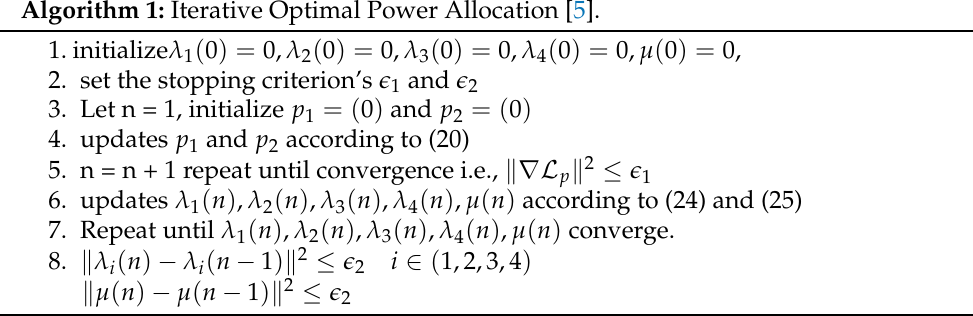
Algorithm 1: Iterative Optimal Power Allocation